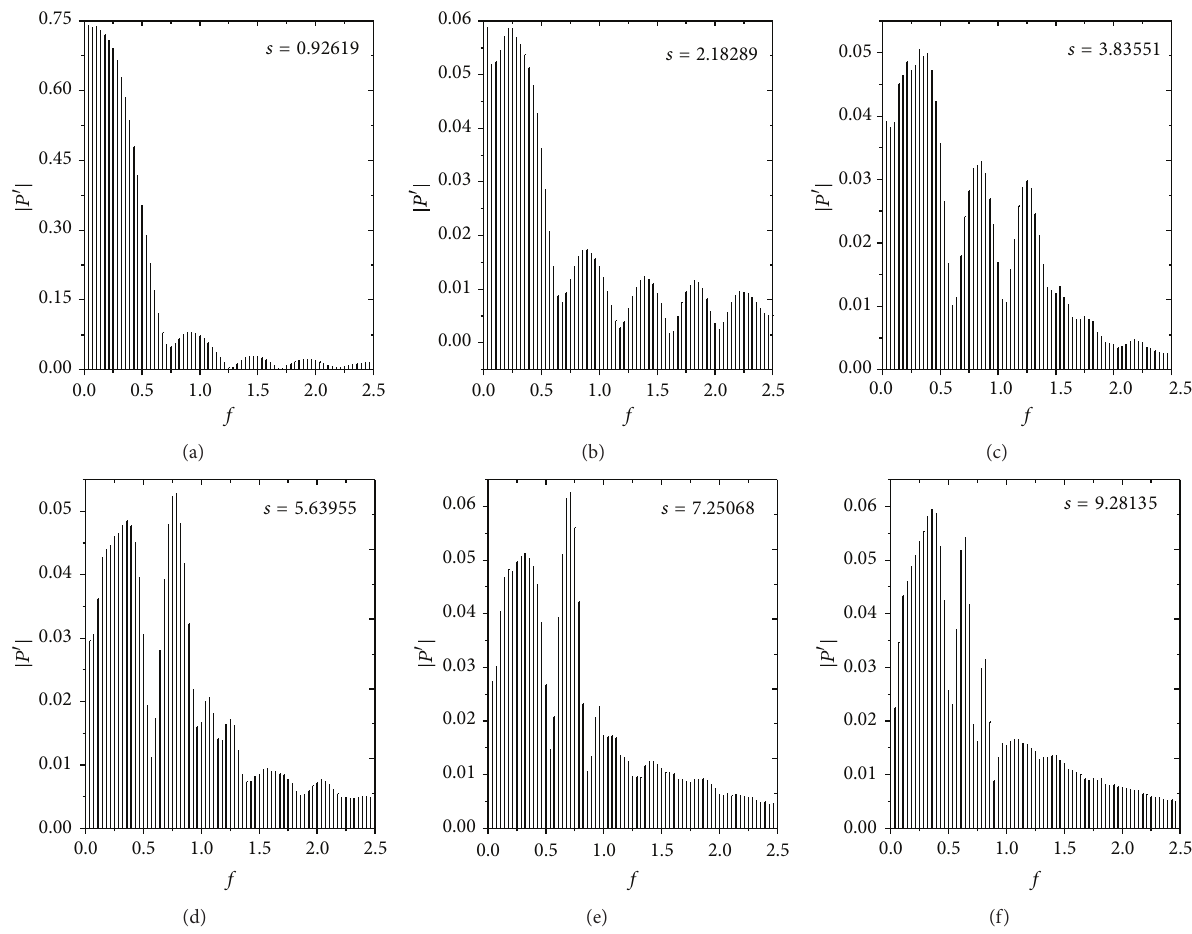
Figure 8: Fourier frequency analysis of pressure disturbance at different surface locations under freestream pulse fast acoustic wave.